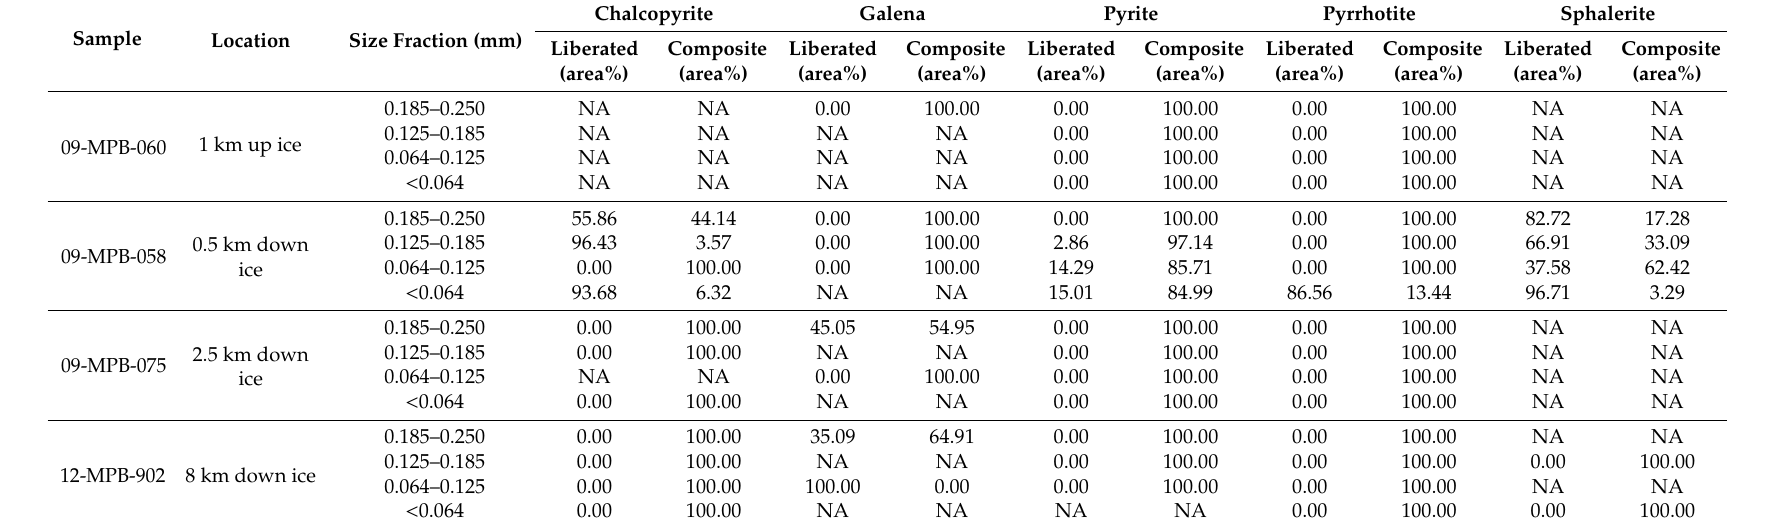
Table 5. The proportion (area %) of each ore mineral present as either liberated grains or as a component in a composite particle.